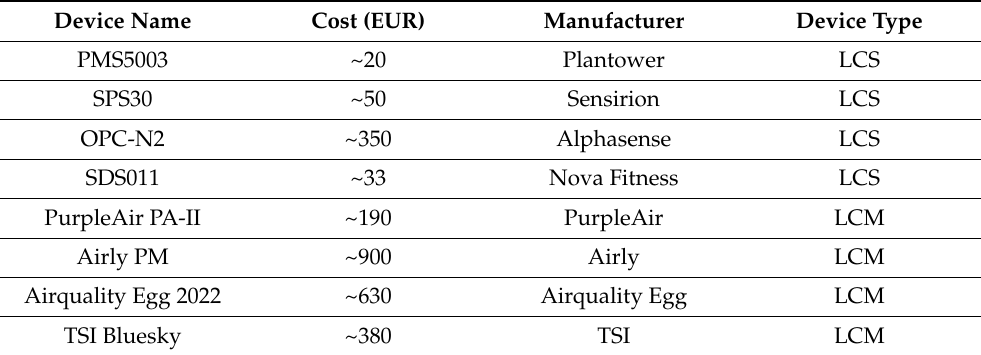
Table 2. A summary of some LCMs/LCSs for PM measurements currently available on the market with their indicative costs and